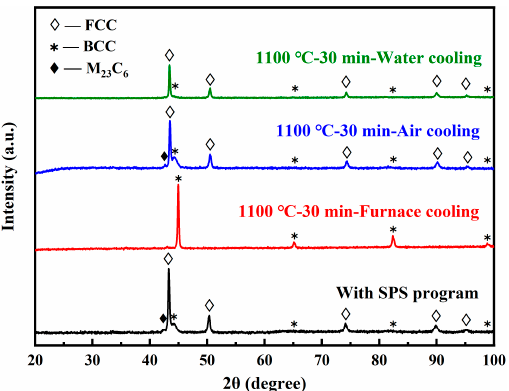
Figure 10. XRD patterns of the sintered specimens before and after different heat treatments.